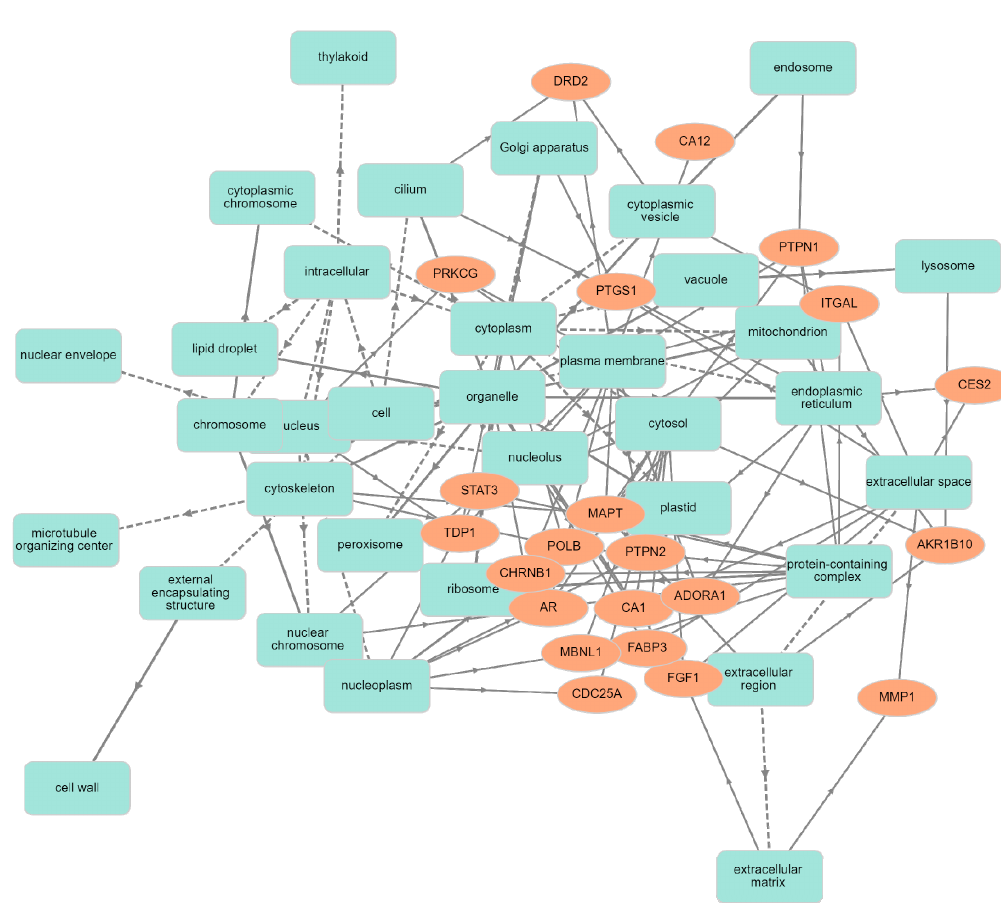
Figure 3. Classification human targets with corresponding cellular component. Orange color encodes human targets; green color represents cellular components.